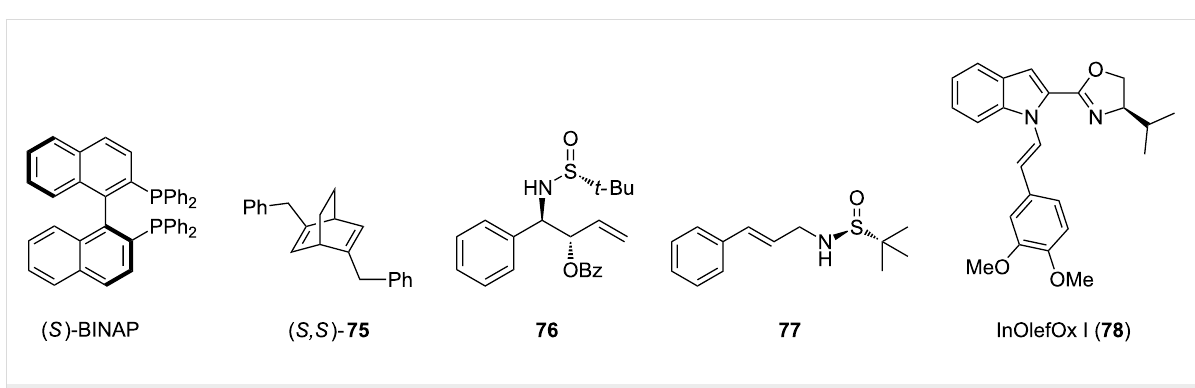
Figure 5: Further chiral ligands that have been used in rhodium-catalyzed 1,4-additions of α , β -unsaturated amides and lactams.